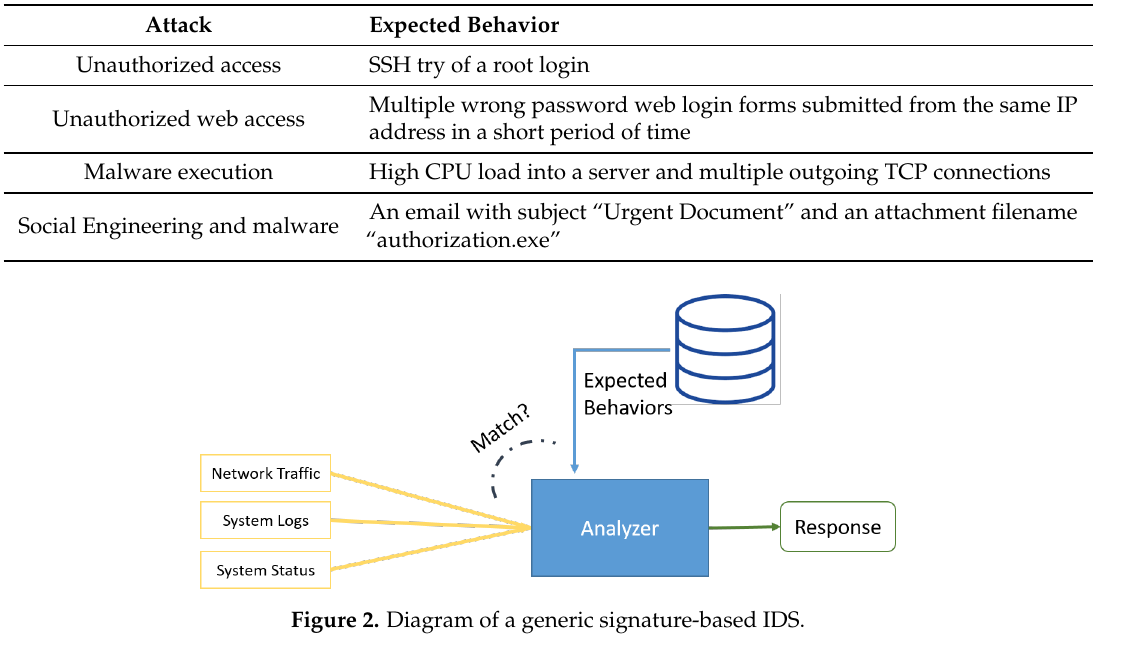
Table 1. Known attacks and their expected behavior.